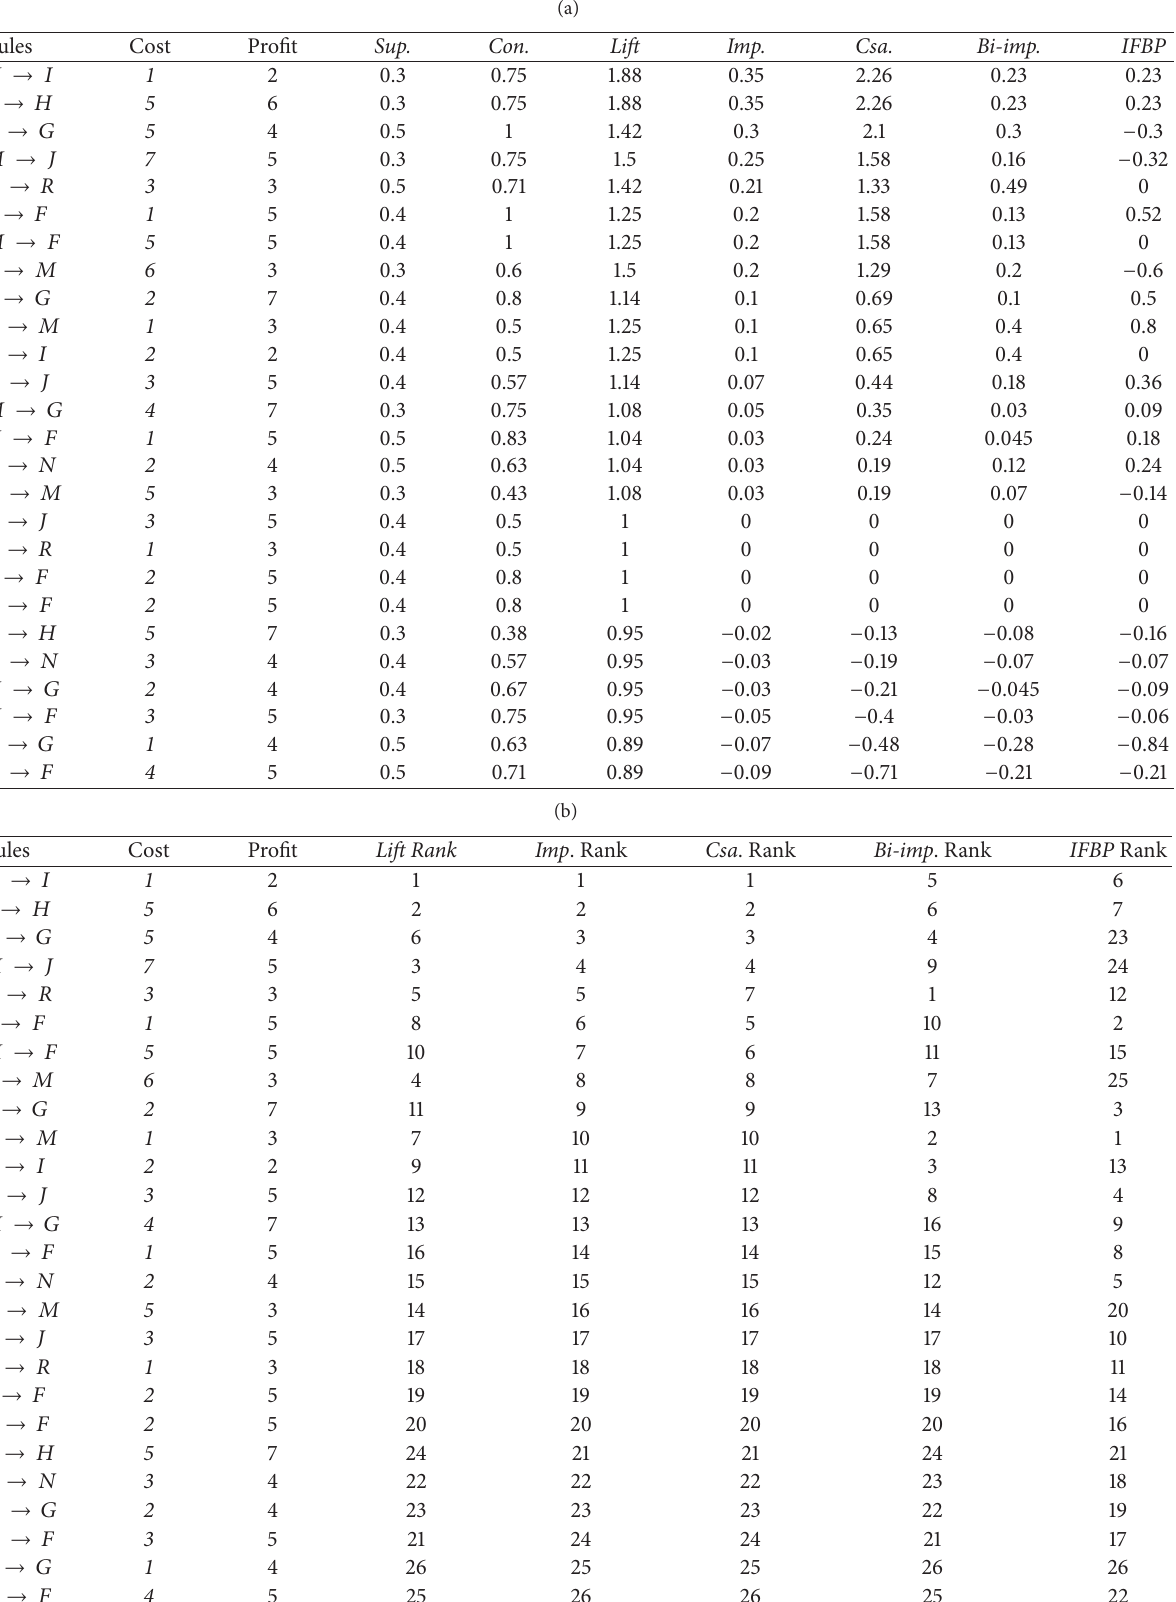
Table 8: Various measure evaluation results of various